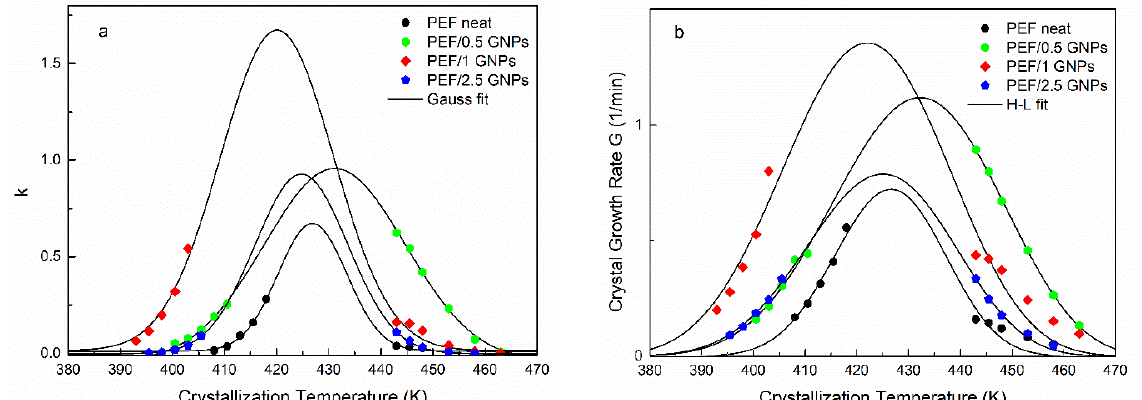
Figure 5. Crystallization rate constant k calculated by Avrami analysis together with the Gaussian fitting ( a ) and crystal growth rate, as well as the Hoffman–Lauritzen fittings for the isothermal melt and glass crystallization ( b ) vs. selected isothermal crystallization temperatures of the neat PEF and PEF/GNP nanocomposites.